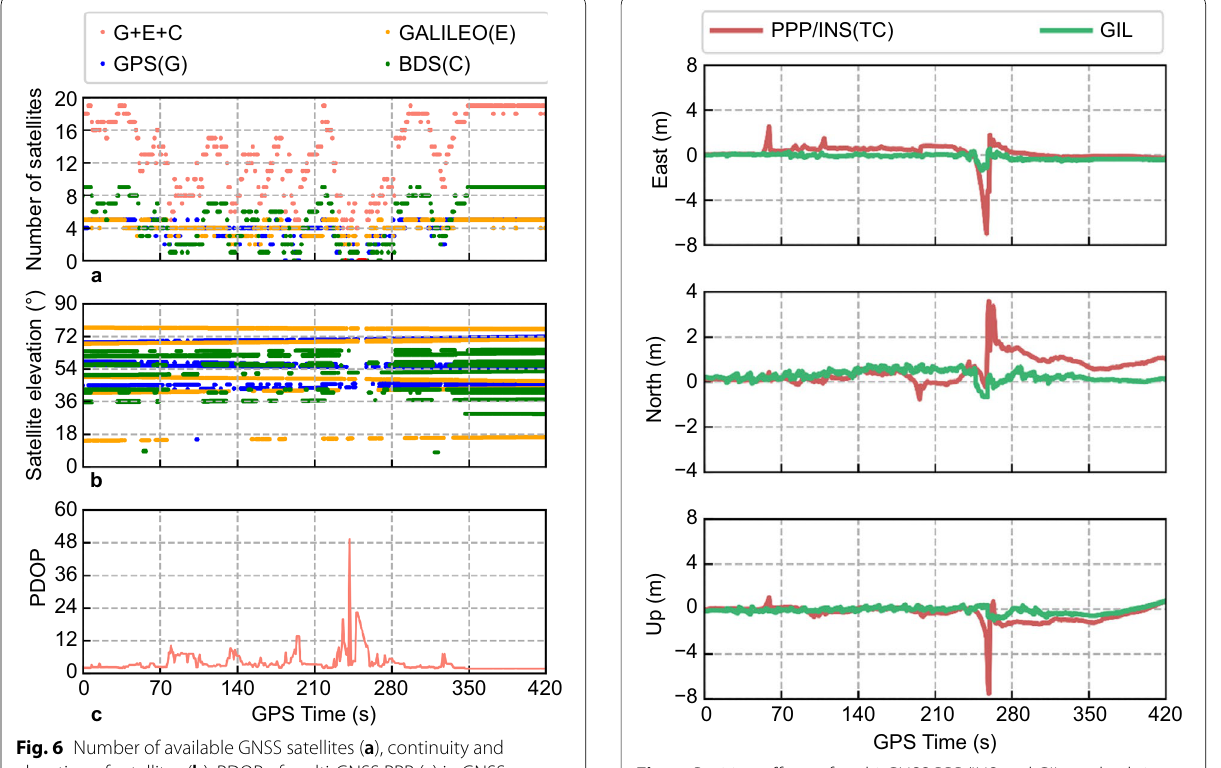
Fig. 7 Position offsets of multi-GNSS PPP/INS and GIL methods in GNSS partly-blocked